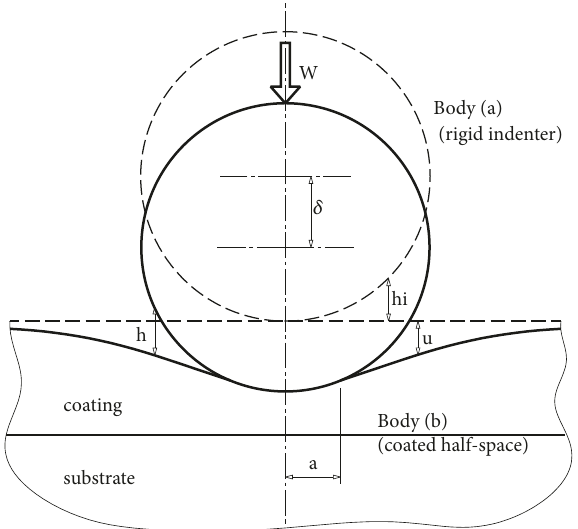
Figure 1: Indentation of a coated half-space by a rigid